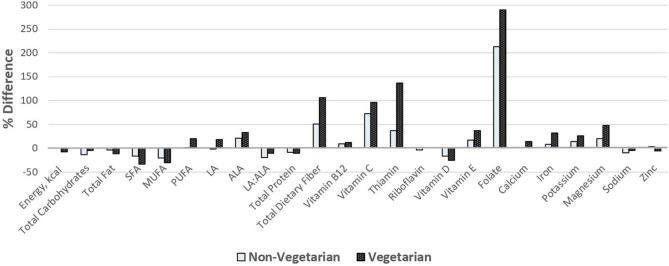
Percent difference in food group intake of vegetarian and non-vegetarian participants compared to the average intake of the US adolescent population. Comparisons were made using data from Usual Dietary Intakes: Food Intakes, US Population, 2007–2010 (30). Bars above the reference “0” line indicate higher intake while bars below the line indicate lower intake compared to the average intake of US adolescents.